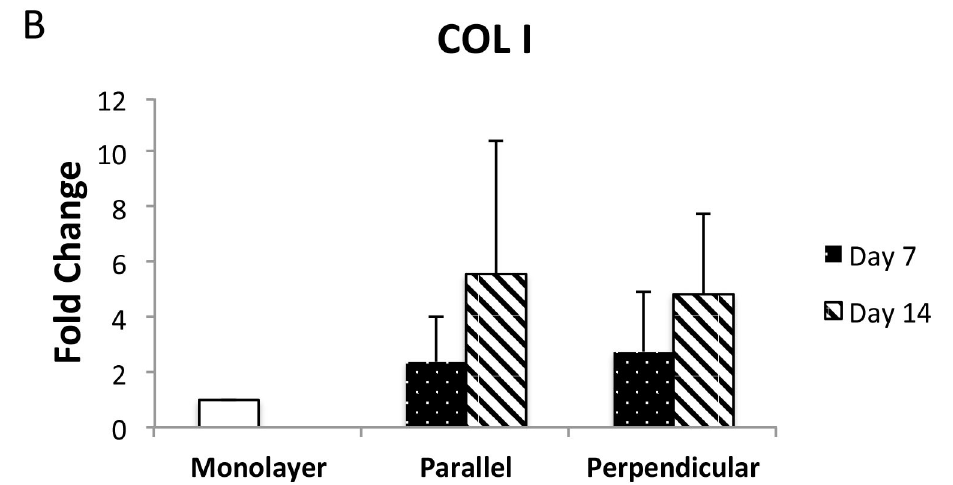
Figure 6. qPCR of MSCs from aligned scaffolds. Gene expression analysis of scleraxis ( A ) and type I collagen ( B ) from equine bone marrow MSCs collected from monolayers, aligned parallel scaffolds, and aligned perpendicular scaffolds on days 7 and 14. Genes were normalized to GAPDH (Glyceraldehyde 3-phosphate dehydrogenase). Gene expression of MSCs from scaffold designs is relative to monolayer controls. p -values ≤ 0.05 were considered significant. Error bars represent SEM.